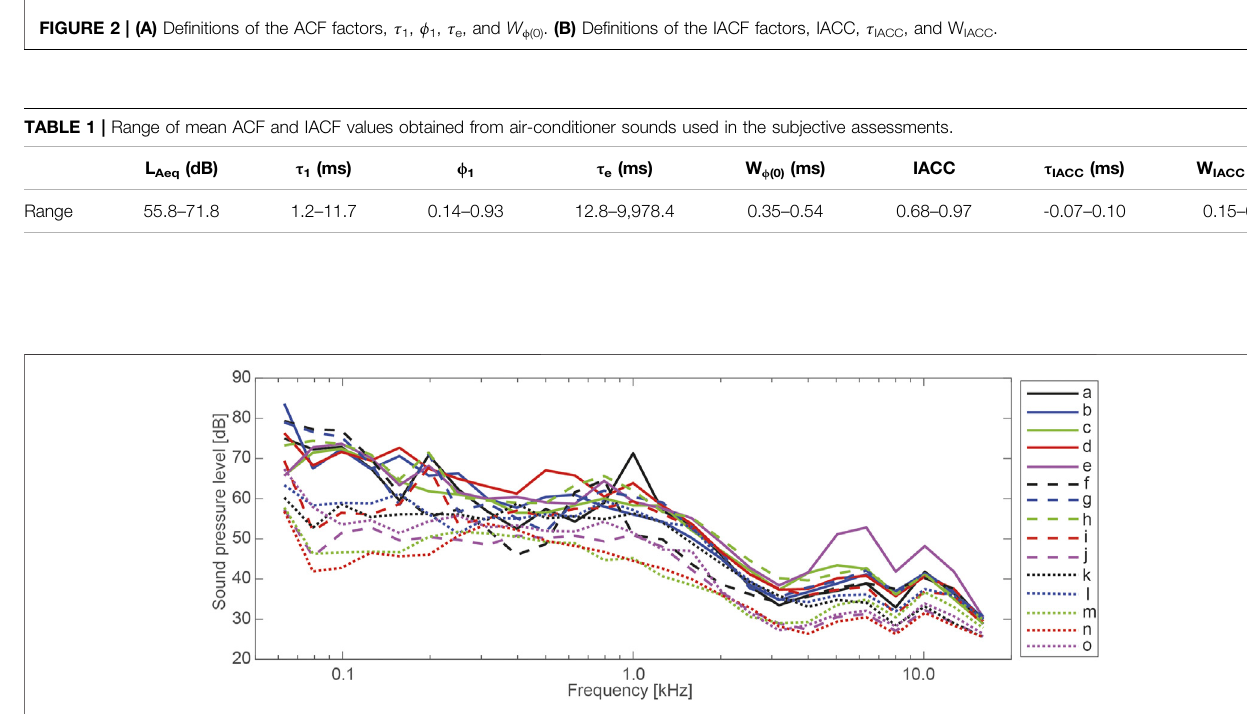
FIGURE 3 | Measured one-third octave band spectra for 15 sounds used in the subjective assessments.